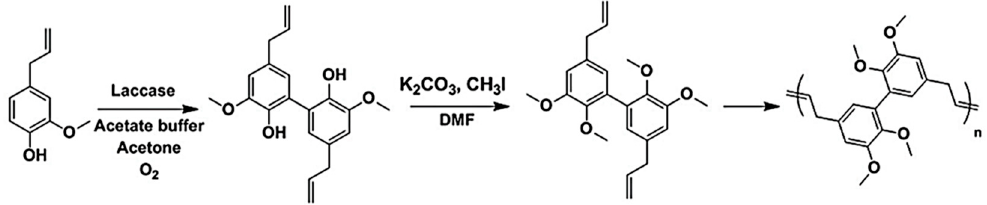
Figure 15. Divinyl compound synthesis from divanillin and ADMET polymerization. Reproduced with permission [54].